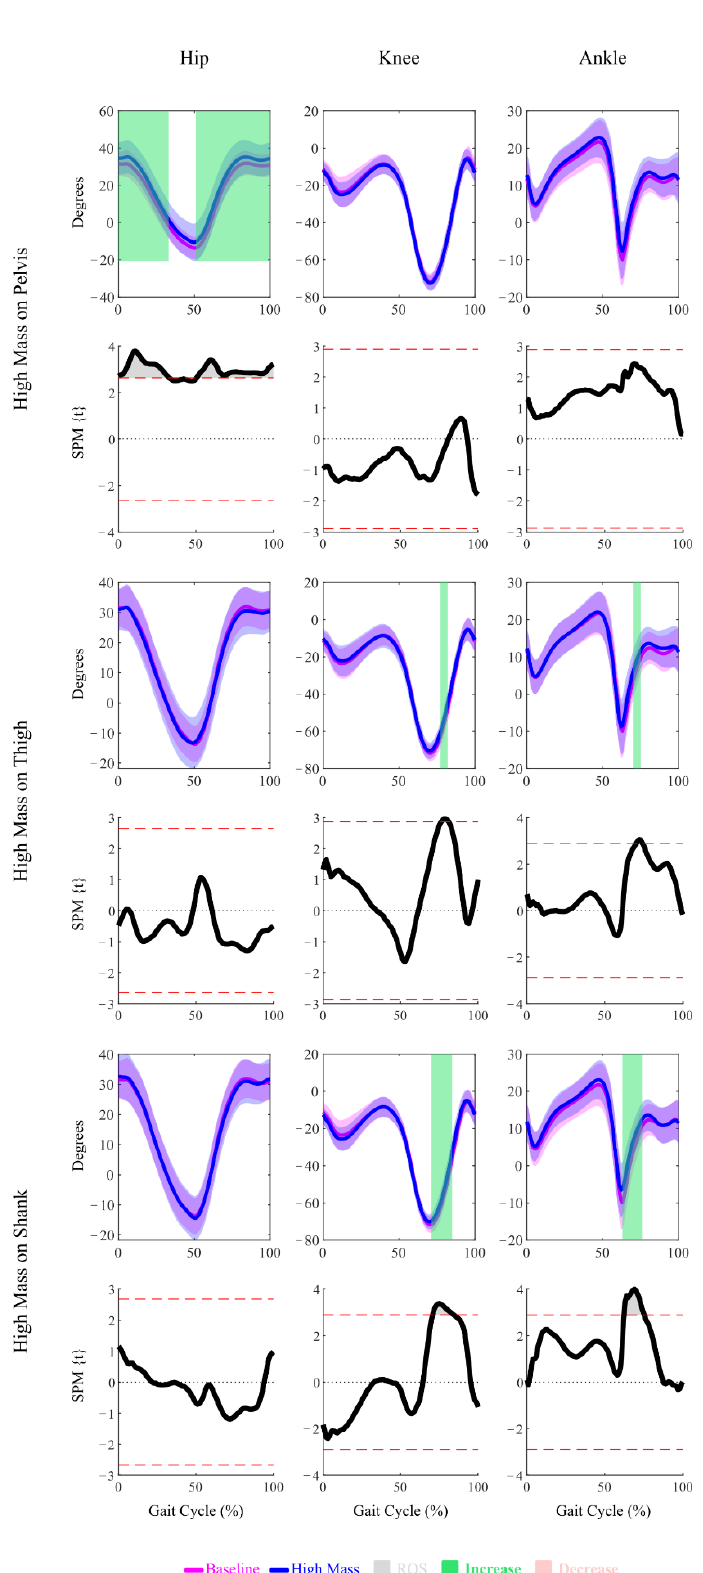
Figure 3. Mean and Standard Deviation plots of the joint kinematics under both the High Mass conditions and the Baseline condition, and SPM{t} plots demonstrating the significance (Region of Significance, or ROS) of the comparisons between the High Mass and the Baseline conditions. Upon significance, directions of changes are highlighted in color.